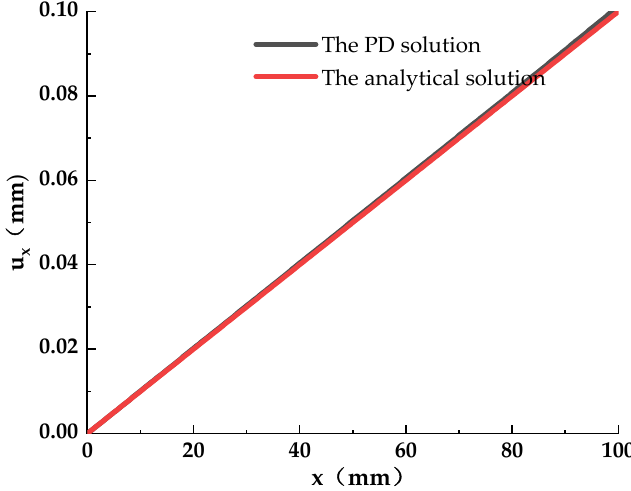
Figure 3. Comparison of displacement curves.